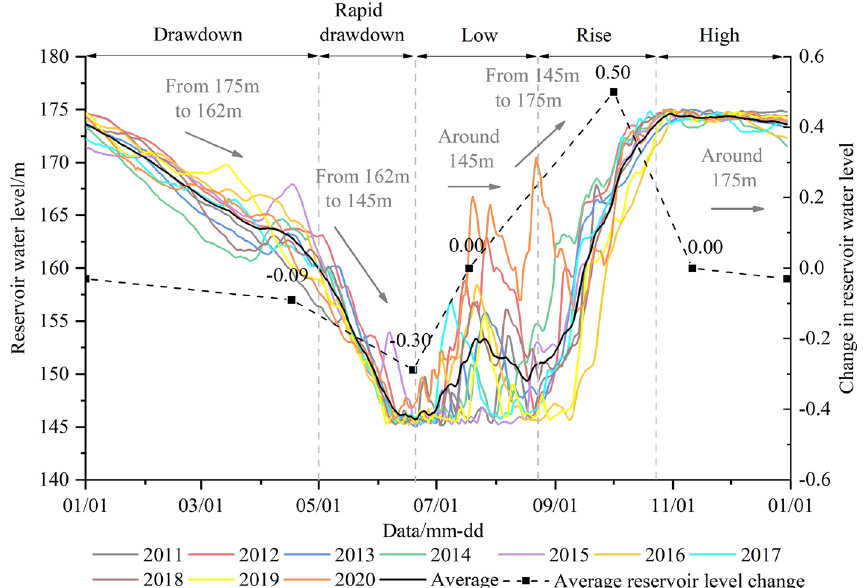
Figure 12. Annual variation of reservoir water level.